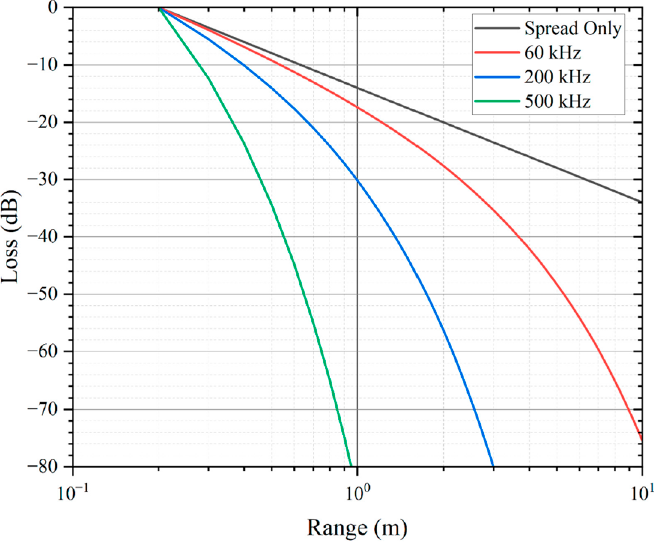
Figure 5. The transmission loss in a spread-only situation without absorption and in-air absorption situations with different frequencies at 20 ℃ and 50% air humidity. Reproduced with permission from [31] , Copyright 2022, MDPI AG.